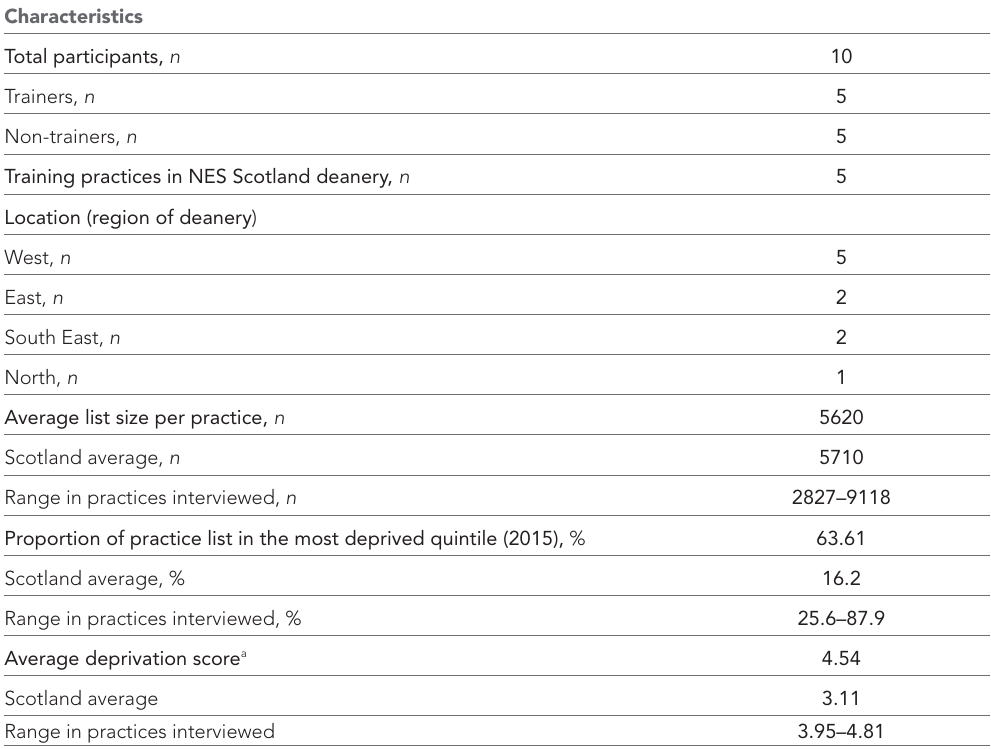
Table 1 Table summarising characteristics of study practices with comparison, where relevant, to Scottish average